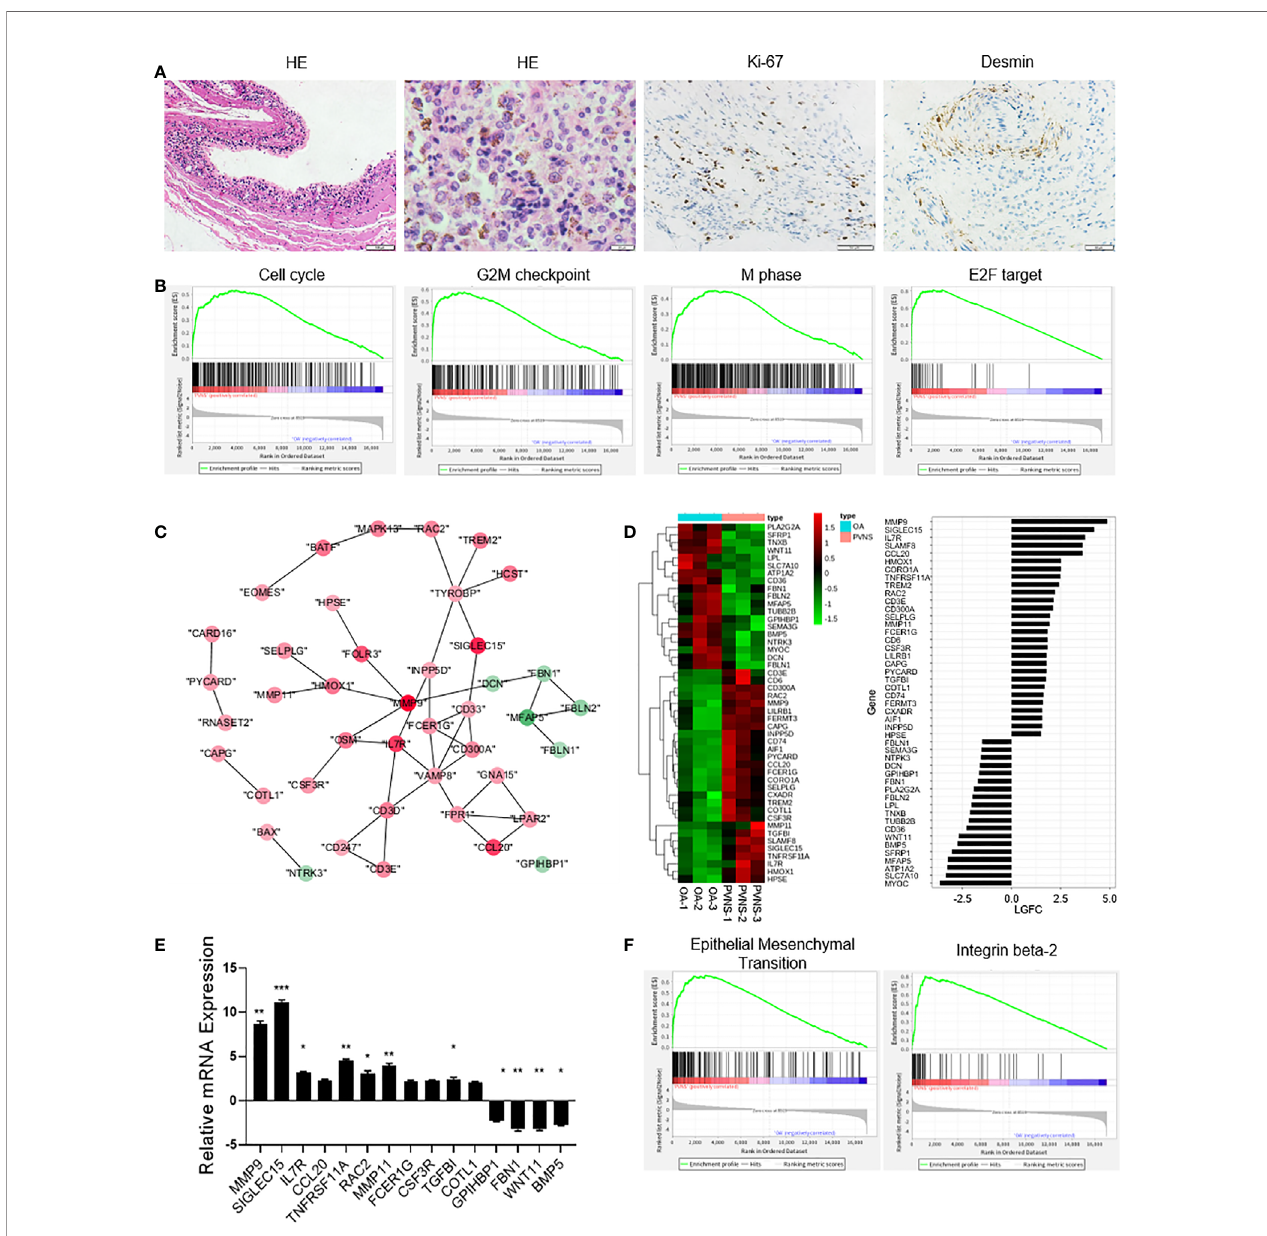
FIGURE 4 | Increased cell proliferation and cell migration in pigmented villonodular synovitis (PVNS). (A) Hematoxylin and eosin staining and immunohistochemical staining for Ki-67 and desmin in PVNS synovium. (B) Gene set enrichment analysis plot depicting the enrichment of differentially expressed genes (DEGs) in cell cycle, G2M checkpoint, M phase, and E2F targets in PVNS synovium (p-value < 0.05). (C) Differential gene expression data of cell migration between PVNS and osteoarthritis (OA) patient samples were analyzed with Cytoscape to identify the regulated subnetworks using known disease gene association. Nodes are colored to determine the fold change. (D) Heatmap shows the gene expression between PVNS and OA patient samples for migration subnetwork. Fold change of representative DEG.s were also shown. (E) Real-time quantitative polymerase chain reaction assay for the representative DEGs to validate the result of functional enrichment analysis. Data in the bar graphs are presented as the means and standard deviations of three independent experiments. One-sample t-test was applied to the fold induction. * p -value < 0.05, ** p -value < 0.01, *** p -value < 0.005. (F) Gene set enrichment analysis plot depicting the enrichment of DEGs in epithelial-mesenchymal transition and integrin beta-2 in the PVNS synovium ( p -value <